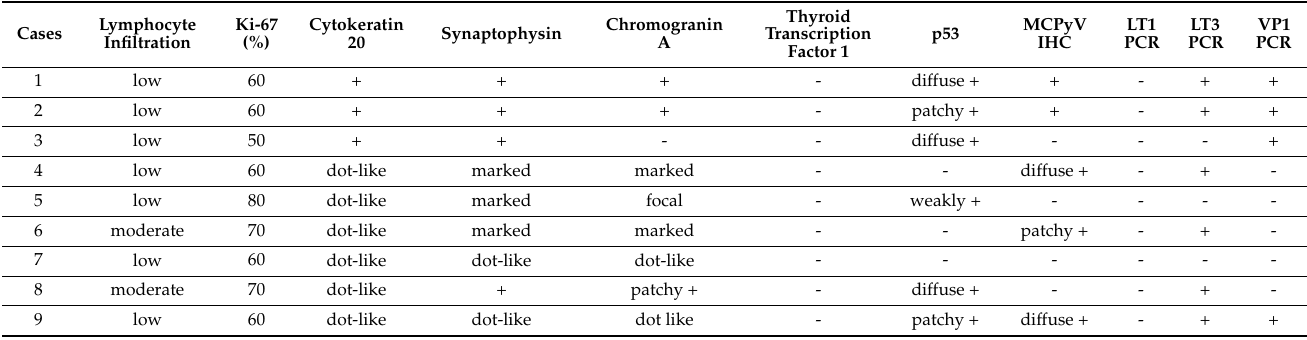
Table 2. Immunohistopathological and PCR features of the MCC